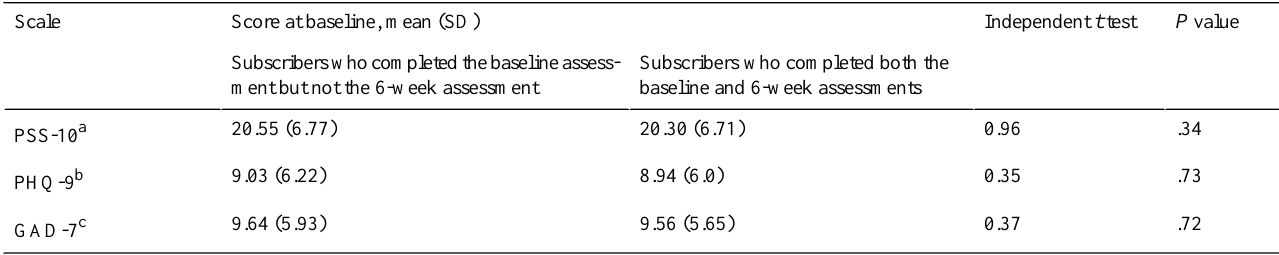
Table 5. Comparison of the mean scores on the PSS-10, GAD-7, and PHQ-9 scales between subscribers who only completed the baseline survey and subscribers who completed both the baseline and 6-week surveys.